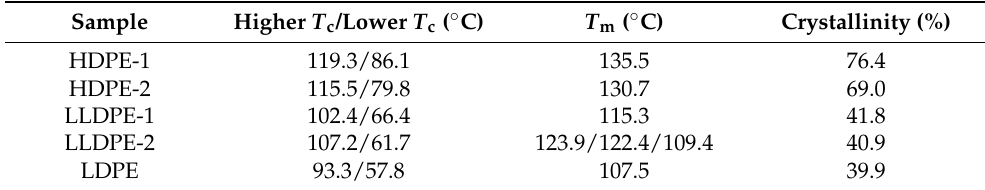
Table 2. Characterization of the neat PEs during DSC cooling and subsequent heating at a given rate of 10 ◦ C